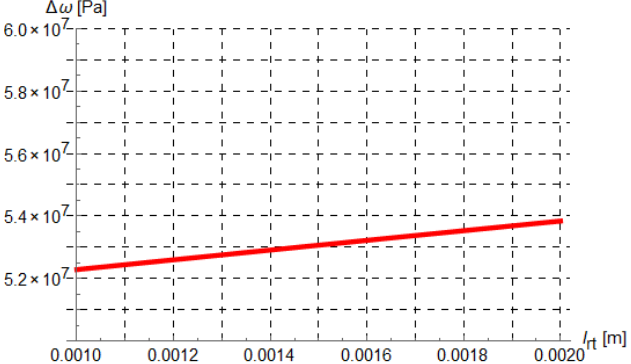
Figure 7. The course of absolute pressure loss ∆ ω , as a function of channel length l rt .